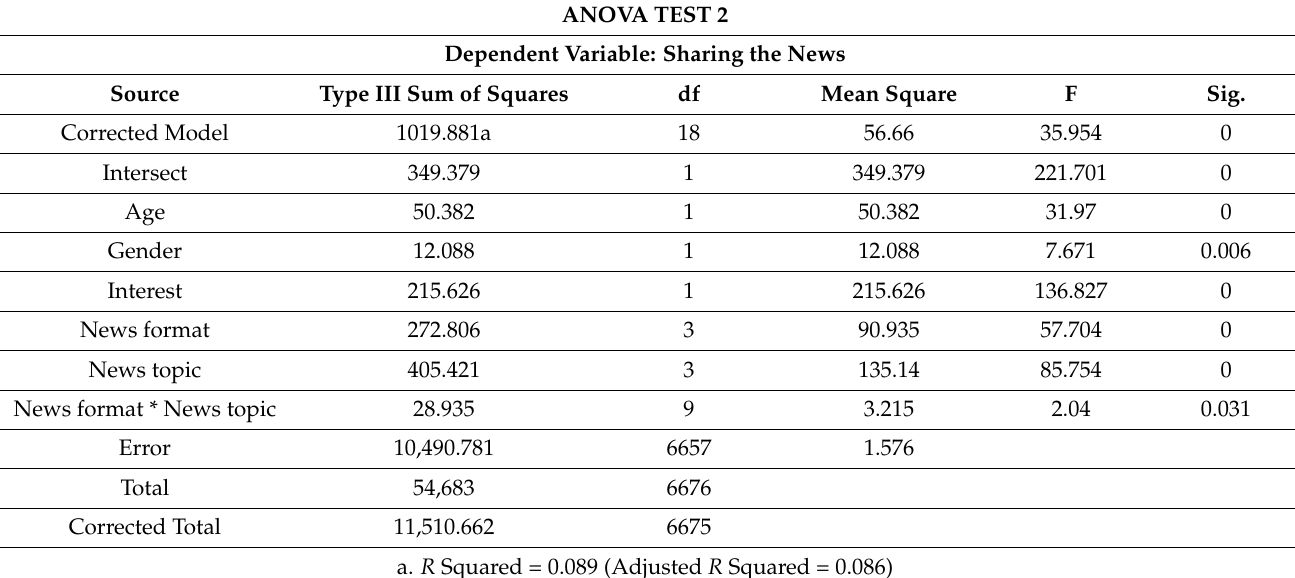
Table 8. ANOVA test. Likelihood of sharing as dependent